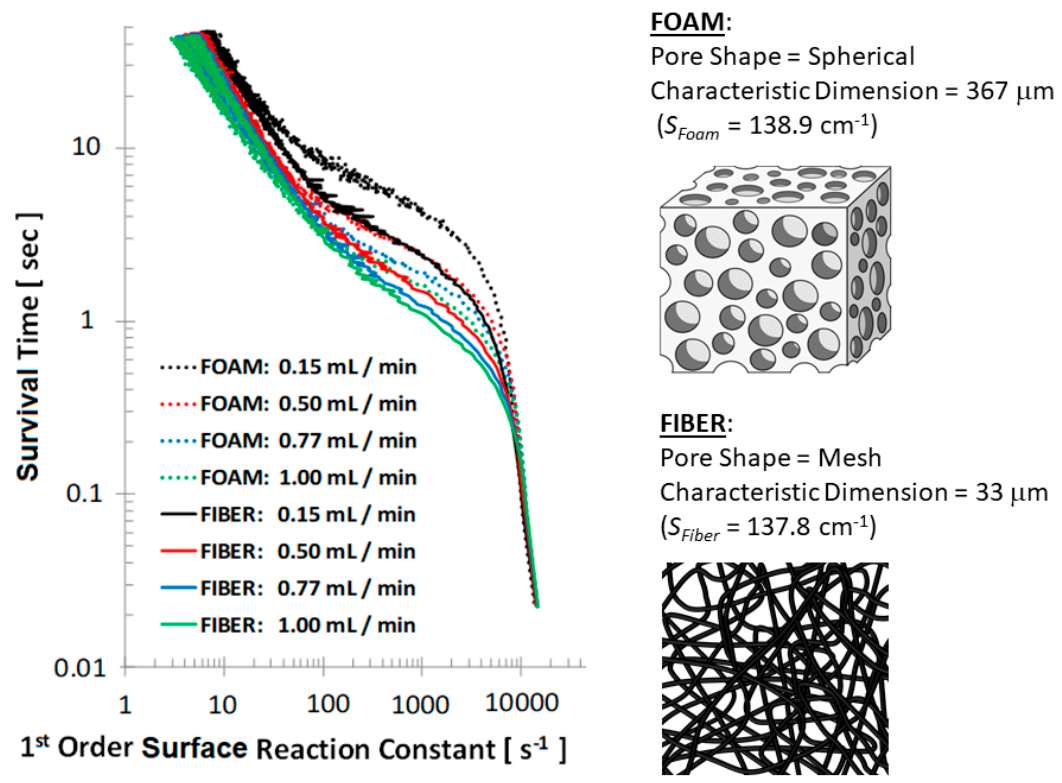
Figure 7. O 2 survival time as a function of the consumption rate by the cells on the scaffold surface. Data is plotted for salt leached foam and non-woven fiber mesh scaffolds at four different flow rates.